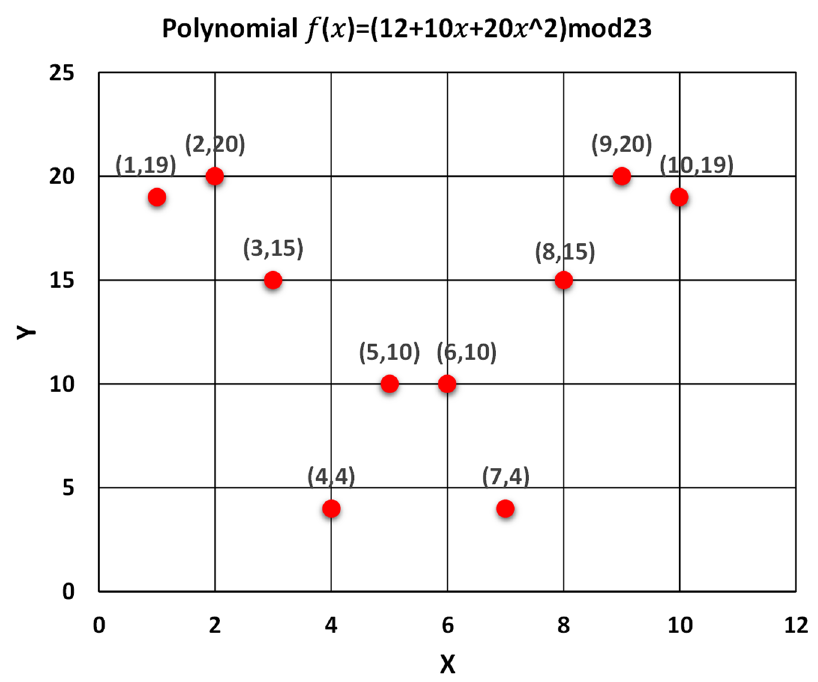
Figure 7. The graphical representation of the generated secret shares over a finite field F 23 Table 3. The generated secret shares by the trusted G.M over the polynomial 𝑓(𝑥) = 12 + 10𝑥 + 20𝑥 (cid:2870) .